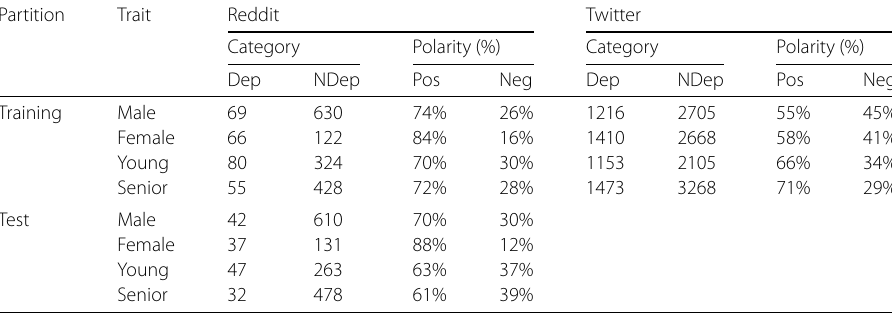
Table 2 Distribution of the type of users and the polarity of their posts in the Reddit and Twitter collections, according to their automatically inferred labels Partition Trait